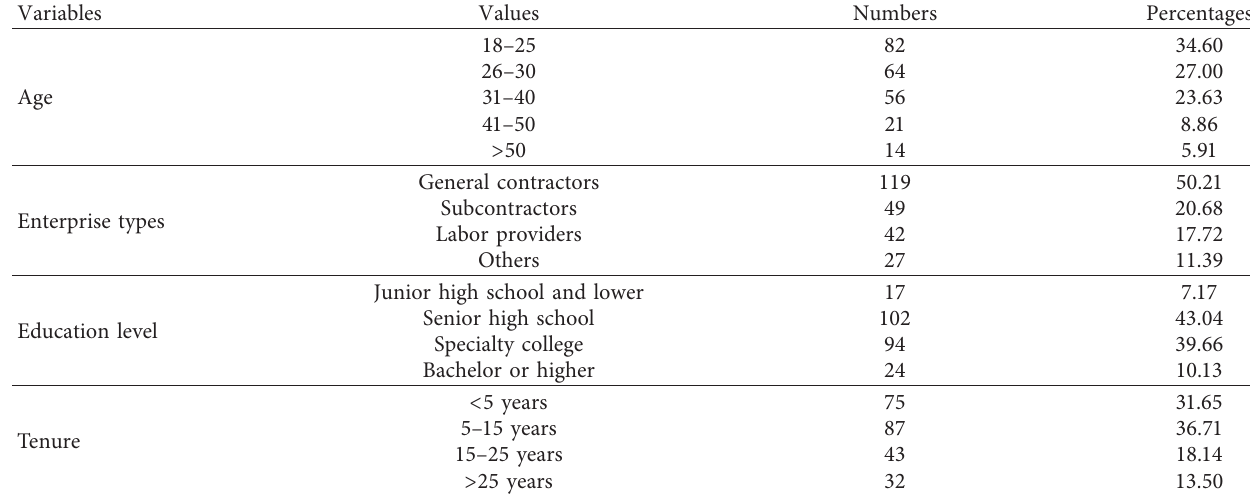
Table 2: Descriptive statistic of the respondents’ demographic information.